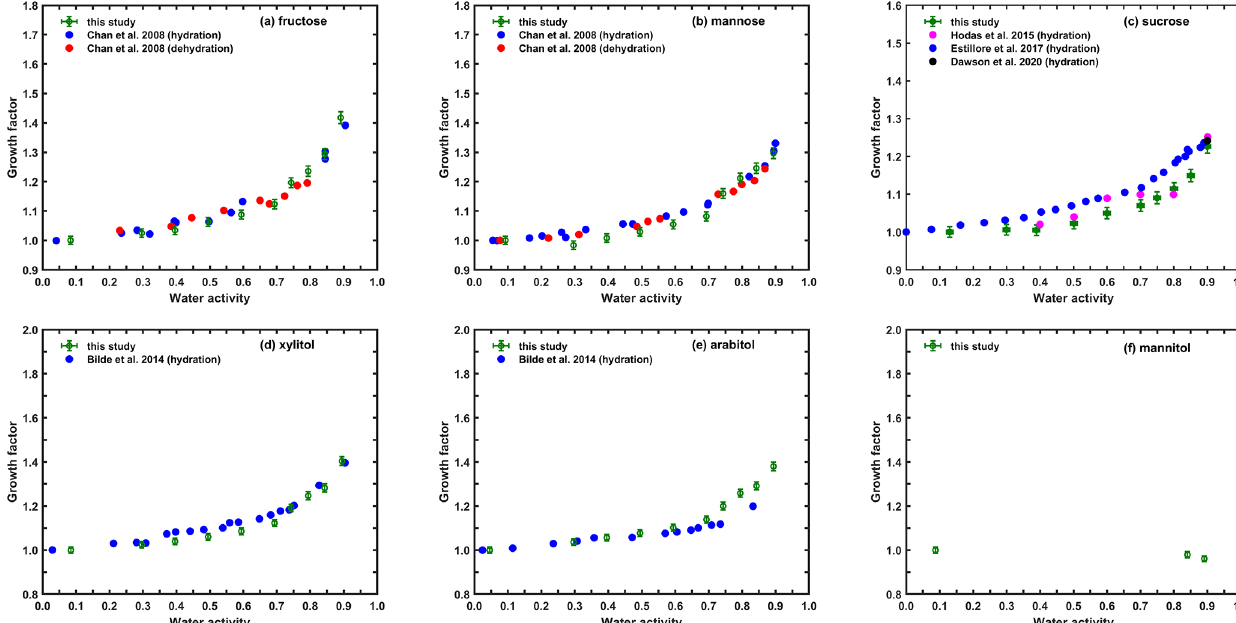
Figure 4. Hygroscopic growth factors of sugars (a–c) and sugar alcohols (d–f) and comparison with previous studies.